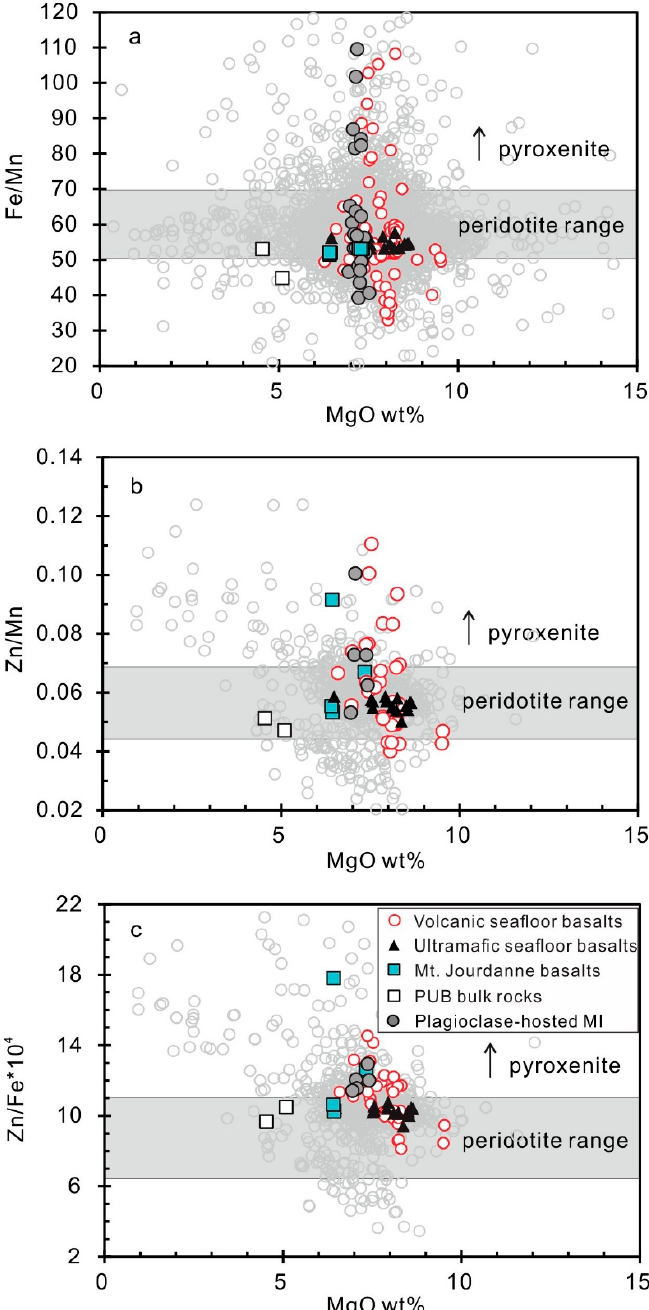
Figure 8. ( a ) Fe/Mn, ( b ) Zn/Mn and ( c ) Zn/Fe × 10 4 versus MgO for Mount Jourdanne basalts and PUBs, plagioclase-hosted melt inclusions and regional basalts from SWIR (61–67° E). Field for peridotite is from Le Roux et al. [62] and MORBs (unfilled grey cycles) are from PETDB database (http://petdb.ldeo.columbia.edu/petdb). Note that some samples have higher Fe/Mn, Zn/Mn and Zn/Fe than the range of MORBs and peridotites, indicating a pyroxenitic component in the mantle